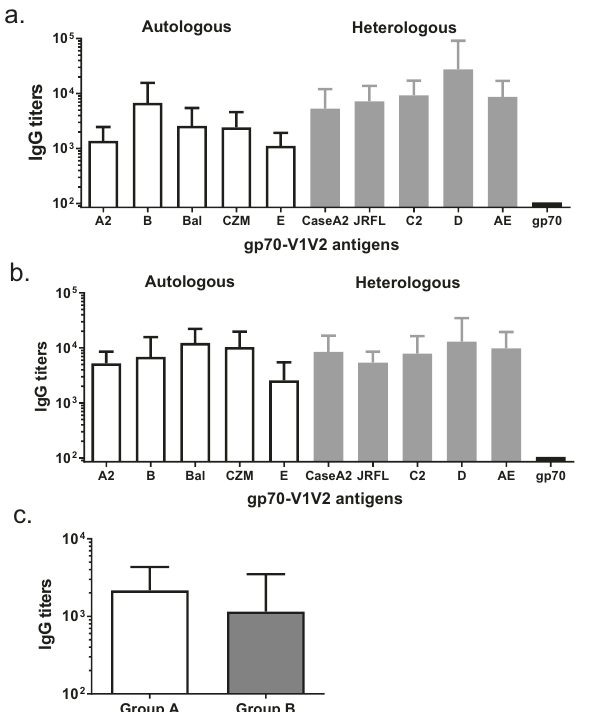
Fig. 4 Detection of gp120 V1V2 speci fi c antibody responses by ELISA. Antibody responses were measured against gp70 scaffold V1V2 antigens from either autologous gp120 or heterologous gp120 using sera from Group A ( a ) or Group B ( b ). Antibody responses against the cyclic V2 (A244) were also measured ( c ). Each bar represents the group mean titer with sera from each volunteer